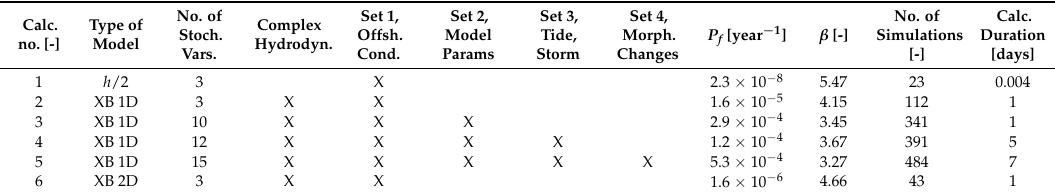
Table 3. Overview of the different probabilistic (ADIS) calculations that were performed with the framework and their